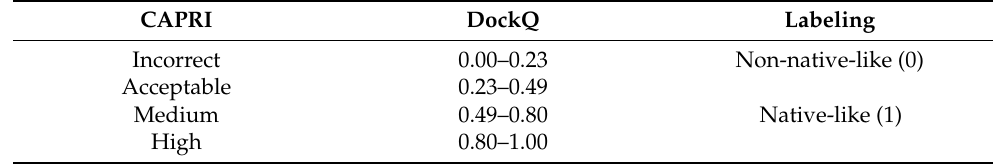
Table 1. Labeling of native-like and non-native-like poses by DockQ score cutoffs. CAPRI DockQ Labeling